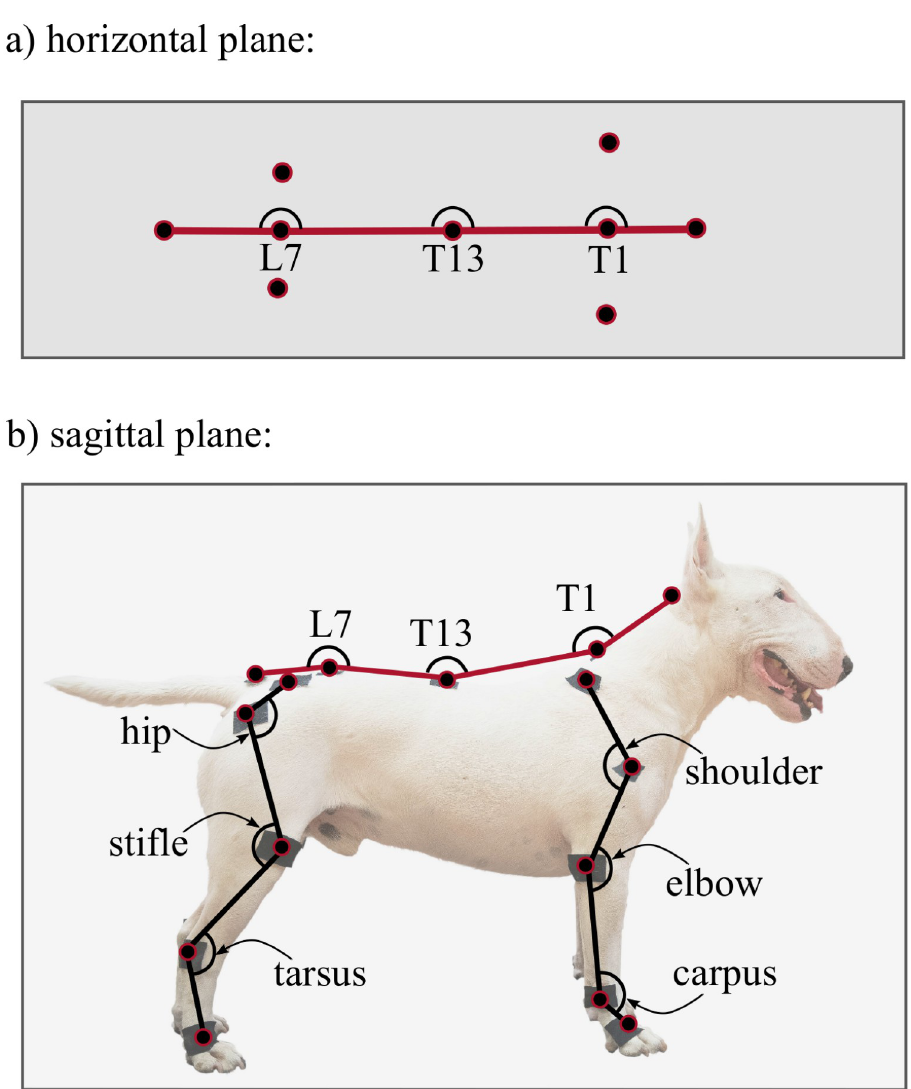
Fig 6. Joint angles in the horizontal and sagittal